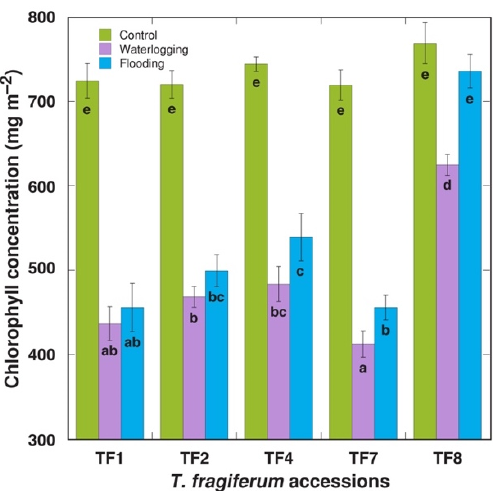
Figure 1. Direct effect of increased soil moisture in the form of waterlogging and flooding on leaf chlorophyll concentration of Trifolium fragiferum plants of different accessions. Measurements were performed after three weeks of treatment. Data are means ± SE from five plants, with three inde- pendent measurements each. Different letters indicate statistically significant differences (p < 0.05).